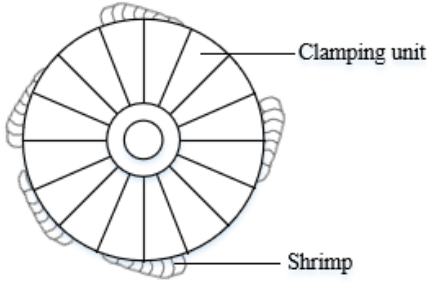
Figure 5. Schematic diagram of segmented shrimp clamping method.